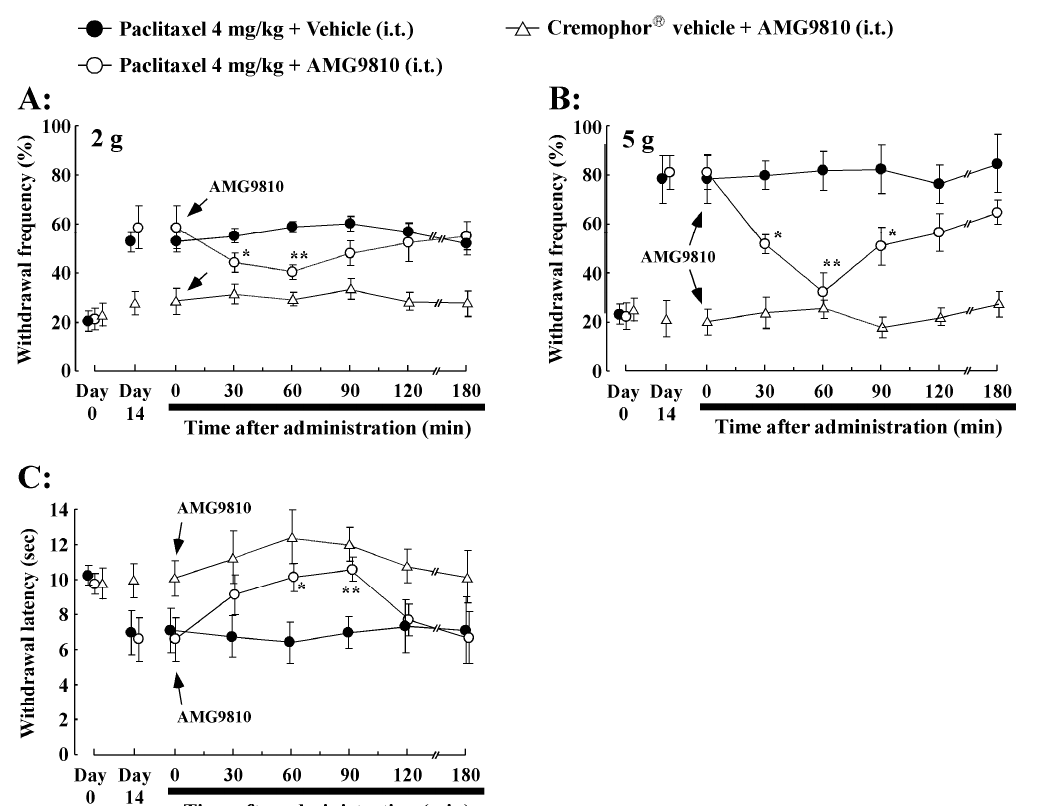
Figure 4. E ff ect of intrathecal administration of TRPV1 antagonist (AMG9810, 35 µ g / 20 µ L) on paclitaxel-induced mechanical allodynia / hyperalgesia and thermal hyperalgesia. ( A ) von Frey test (2 g), ( B ) von Frey test (5 g), and ( C ) paw thermal test were used to measure mechanical allodynia / hyperalgesia and thermal hyperalgesia induced by 4 mg / kg paclitaxel treatment in rats, respectively. Intrathecal administration of AMG9810 (35 µ g / 20 µ L) or Cremophor ® vehicle was conducted at day 14. Paclitaxel-induced mechanical allodynia / hyperalgesia and thermal hyperalgesia were significantly inhibited by AMG9810. Data are the mean ± SEM of n = 8–10 rats. * p < 0.05, ** p < 0.01 from before AMG9810 administration.